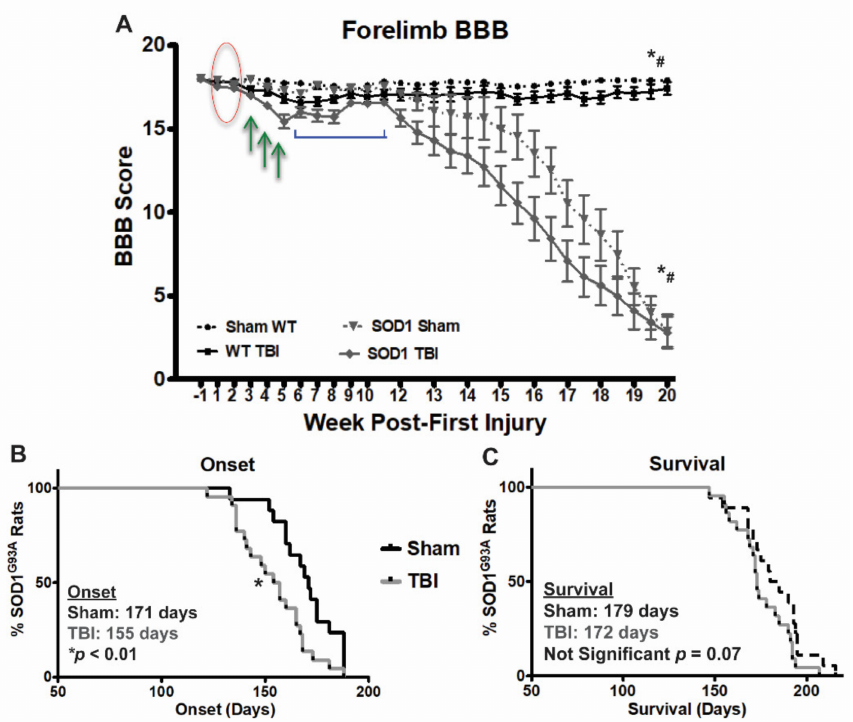
Figure 2. Repetitive bilateral mild TBI results in long-term mild paralysis in WT rats and earlier disease onset in SOD1 rats. ( A ) BBB scoring following repetitive mild TBI revealed no signs of paralysis after the first two weeks of injury (red oval). However, paralysis was observed following the 3rd injury and continued to worsen throughout the course of injury (green arrows). WT rats maintained a mild level of paralysis throughout the length of the study. An improvement in BBB score occurred following the final injury, prior to onset of disease in SOD1 rats (blue bracket). (* SOD1 sham SOD1 TBI, * WT sham vs WT TBI, # SOD1 Sham vs WT Sham, # SOD1 TBI vs WT TBI, Two-way ANOVA p < 0 .05) ( B ) Onset of paralysis based on forelimb BBB assessment occurred significantly earlier in SOD1 TBI rats, relative to SOD1 sham rats (155 vs. 171 days, respectively * p < 0.01). ( C ) Earlier onset of disease did not translate to significantly shortened survival time in SOD1 TBI